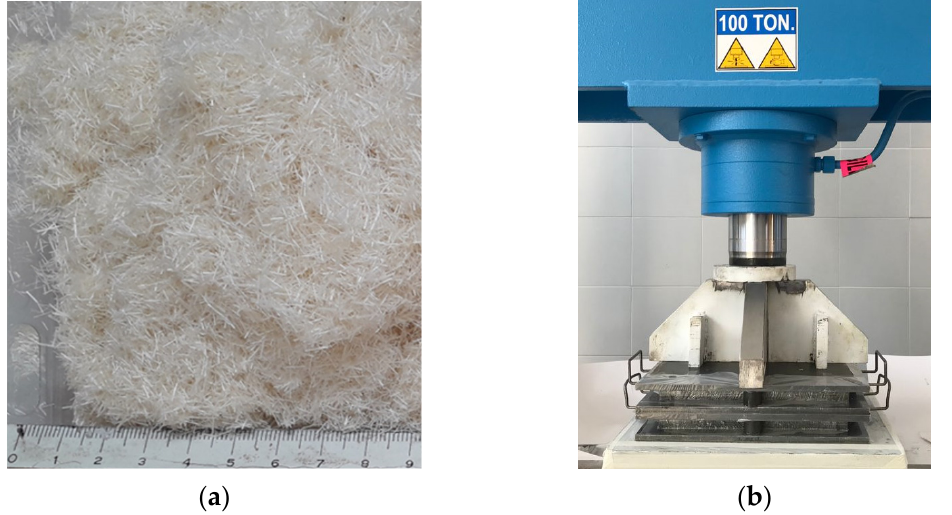
Figure 1. ( a ) Short optimized sisal fibers, ( b ) the double mold and hydraulic press used in the compression-molding operation.